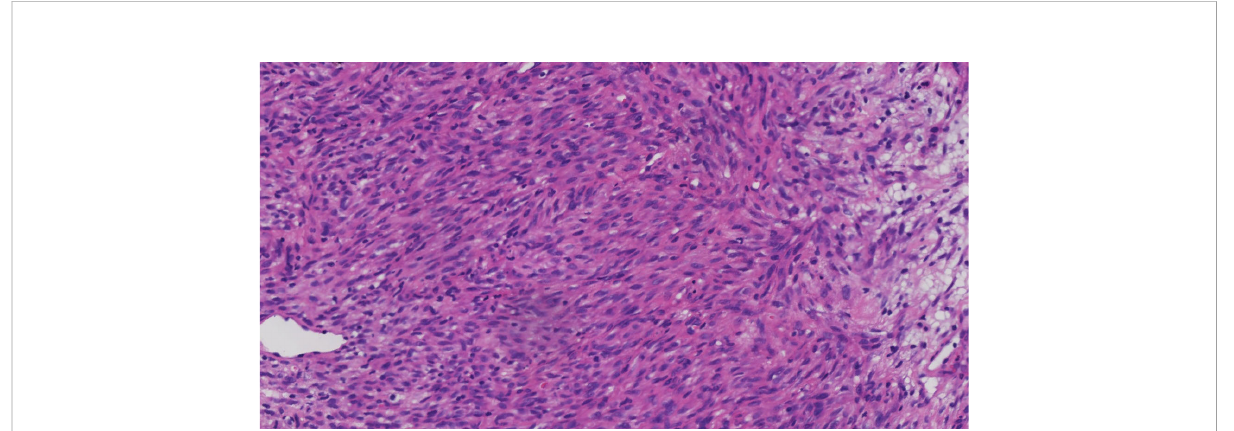
FIGURE 1 Histology sections from biopsy samples showed a spindle cell in fi ltrate with accompanying in fl ammatory stromal cell response (hematoxylin and eosin, original magni fi cation